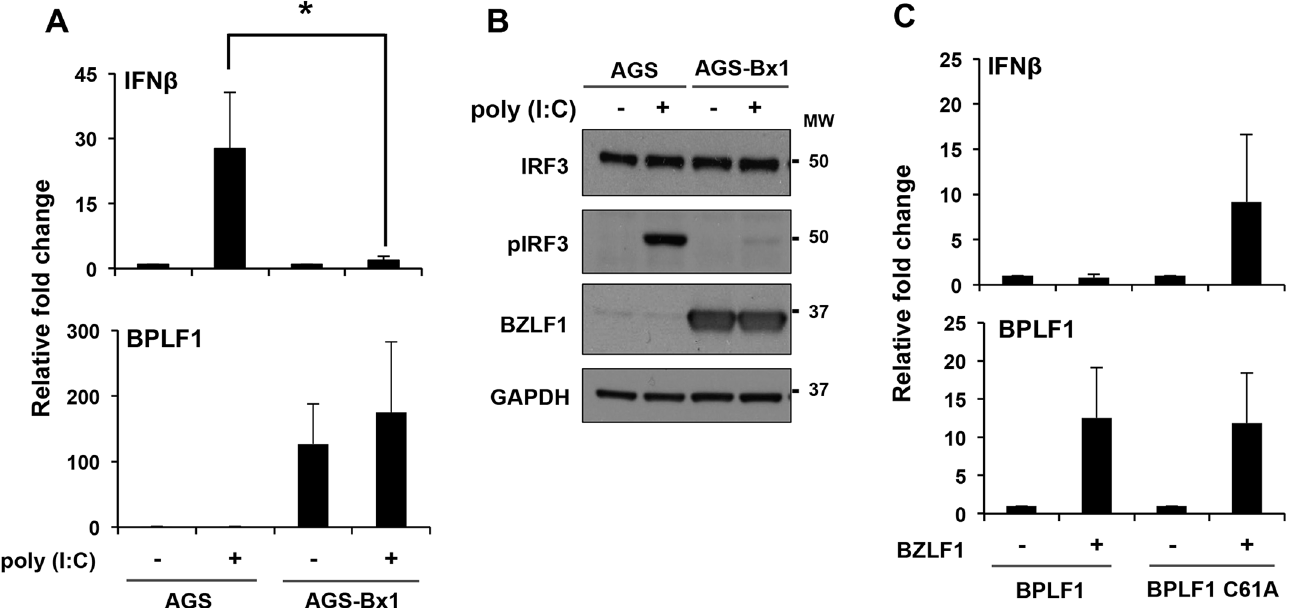
Fig 3. Endogenous BPLF1 inhibits the IFN response upon reactivation of the productive virus cycle. A . EBV negative AGS and the EBV converted AGS-Bx1 cell lines were treated for 48 hrs with TPA/Bu and the IFN response was activated by transfecting with 2 μ g/ml poly(I:C) for 6 hrs. The expression of IFN β and BPLF1 mRNA was quantified by qRT-PCR. The mean ± SD of two experiments is shown. B . Western blots of cell lysates were probed with the indicated antibodies. One representative experiment out of 3 is shown. C . HEK293 cells carrying recombinant EBV strains encoding for WT or C61A mutated BPLF1 were transfected with a BZLF1 plasmid for induction of the productive virus cycle. The transcript levels of IFN β and BPLF1 were quantified by qRT-PCR, using GAPDH as a reference gene. The mean ± SD of 3 independent experiments is shown.